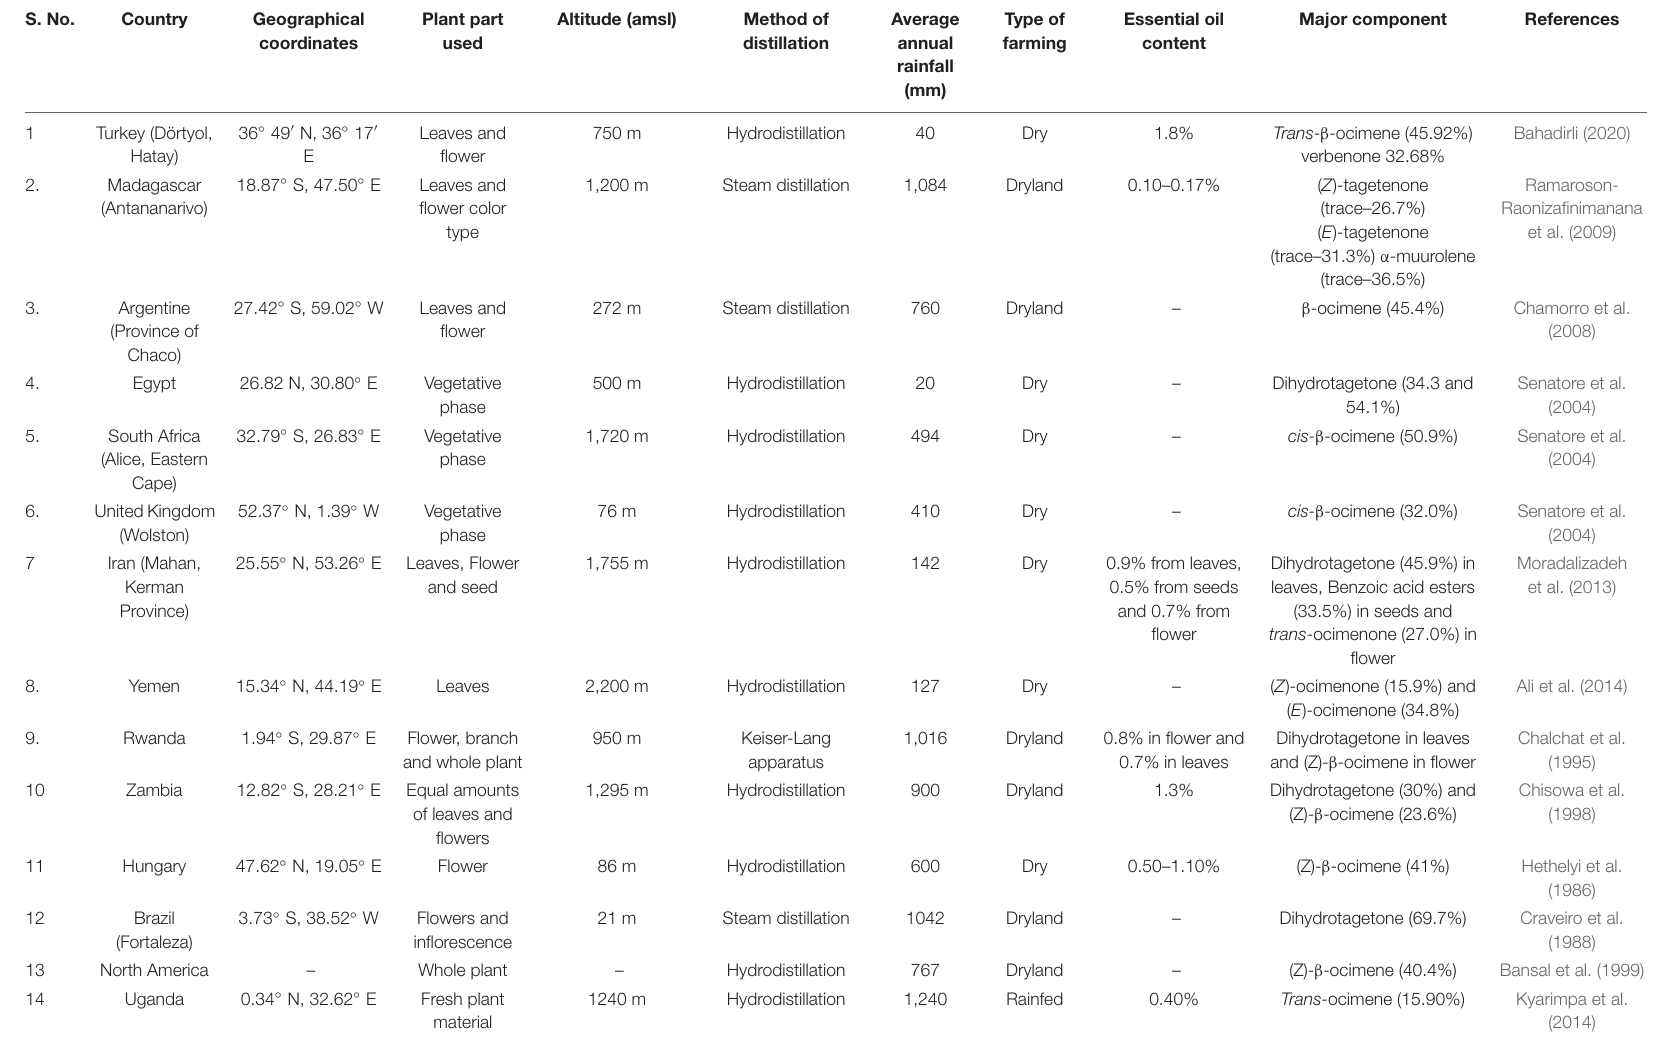
TABLE 2 | Essential oil composition as affected by different geographical locations and altitudes (world). S.